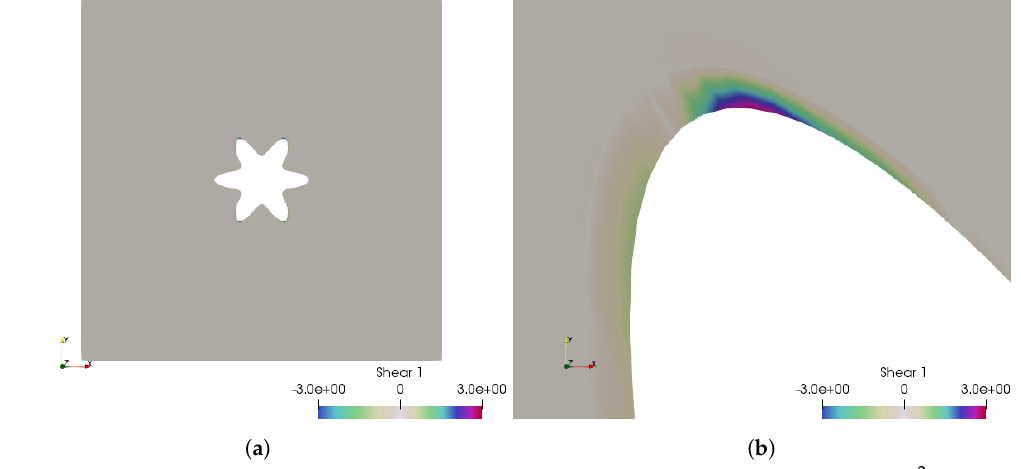
Figure 21. Case 4: the fluid shear stress representation, which is between − 3 and 3 dyn/cm 2 . ( a ) The fluid shear stress overview; ( b ) zoom over the higher shear stress